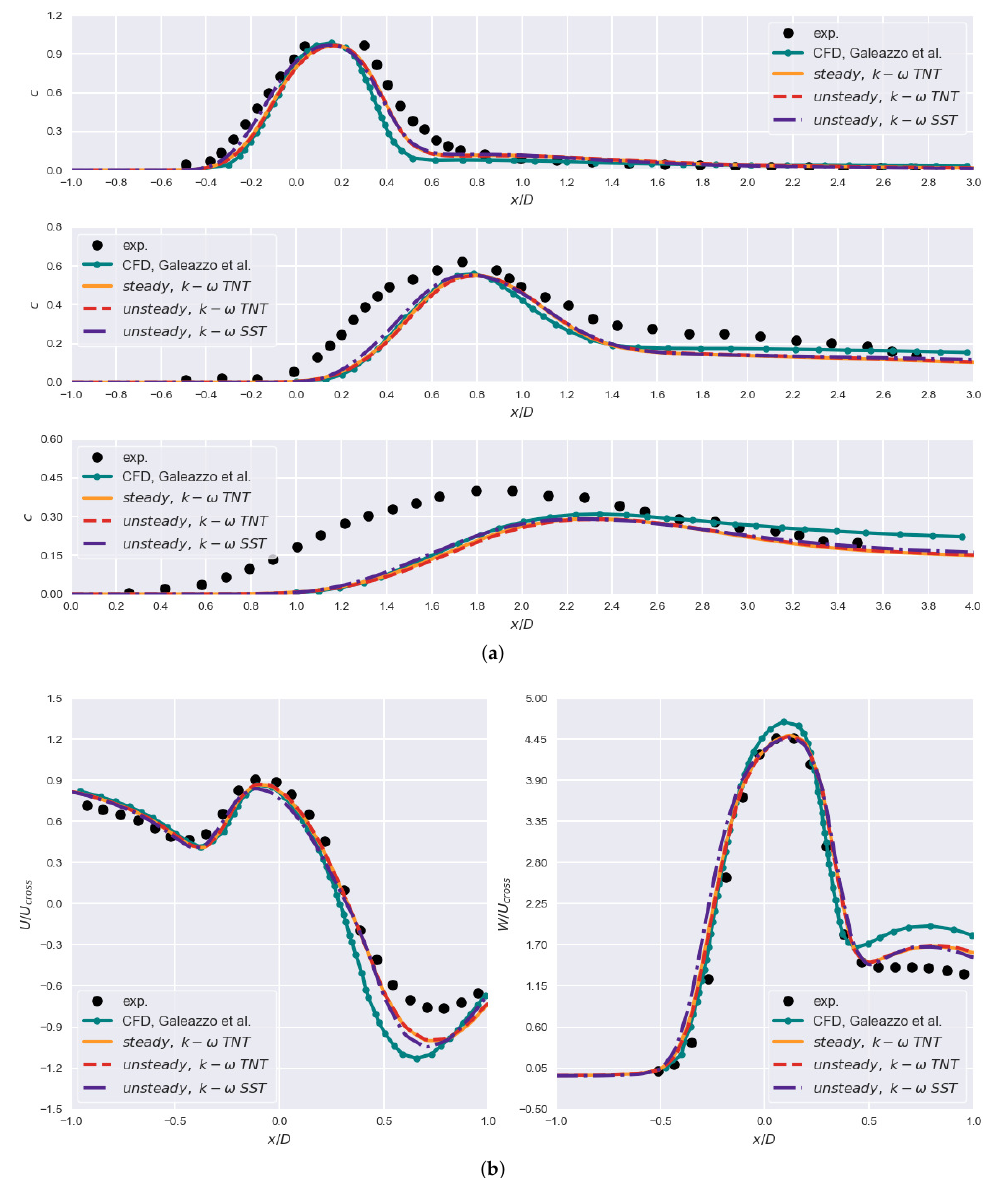
Figure 3. Comparison between the results presented in [15] and results obtained on the fine grid: ( a ) scalar concentration at z / D = 1.5, z / D = 3, z / D = 4.5 (top to bottom) where y / D = 0; ( b ) profiles of mean velocity components for y / D = 0 and z / D =